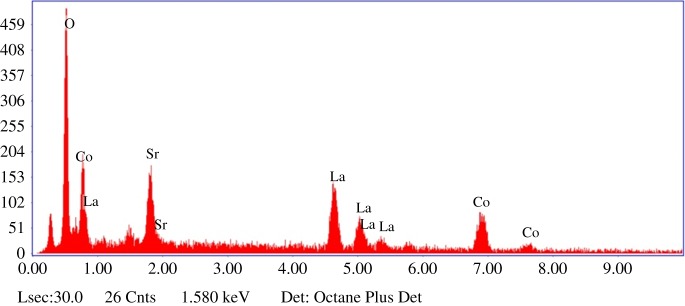
EDX patterns of the La0.6Sr0.4CoO3 perovskite catalyst.